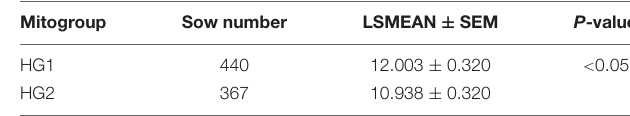
TABLE 2 | Association analysis of TNBs and